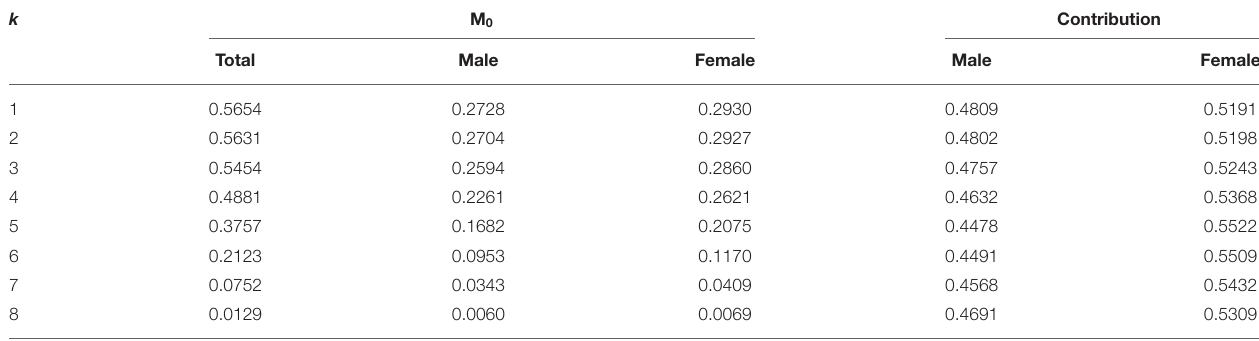
TABLE 4 | Multidimensional disability index (M 0 ) and contribution rate were broken down by gender under different k values. k